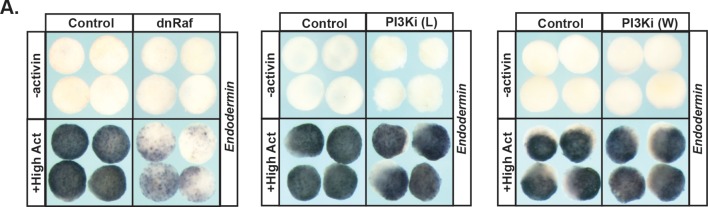
MAPK and PI3K/Akt signaling are differentially required for Endodermin expression.(A) Animal pole explant assay examining expression of Endodermin in explants cultured with or without activin after injection with dnRaf or treatment with PI3Ki (L) (LY294) or PI3Ki (W) (Wortmannin). Explants were cultured alongside sibling embryos and collected at midgastrula stages (stage 11.5). MAPK signaling is required for Endodermin induction.